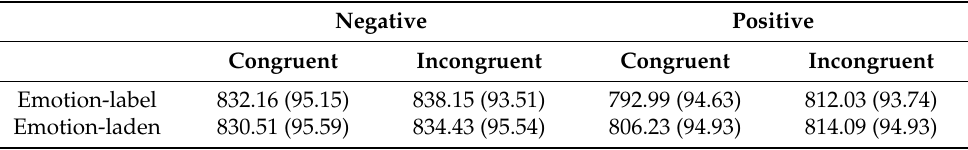
Table 4. Mean reaction time (ms) and accuracy rate (%) in brackets of emotion-label words and emotion-laden words as a function of congruency and valence (Experiment 2). Negative Positive Emotion-label